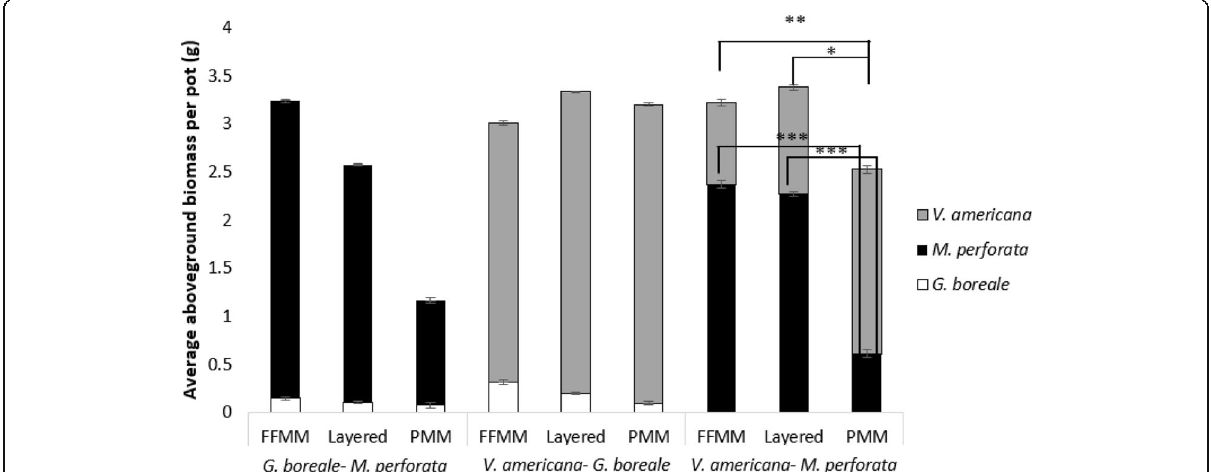
Fig. 3 Average aboveground plant biomass per pot for all competition pot plant species combinations in forest floor-mineral mix, layered, and peat-mineral mix soil types. Bars indicate standard error for each species individually, and asterisks represent p values generated from post hoc analysis (Tukey ’ s test) that compares subset species across soil treatments (*** p < 0.001, ** p < 0.01, * p < 0.05)